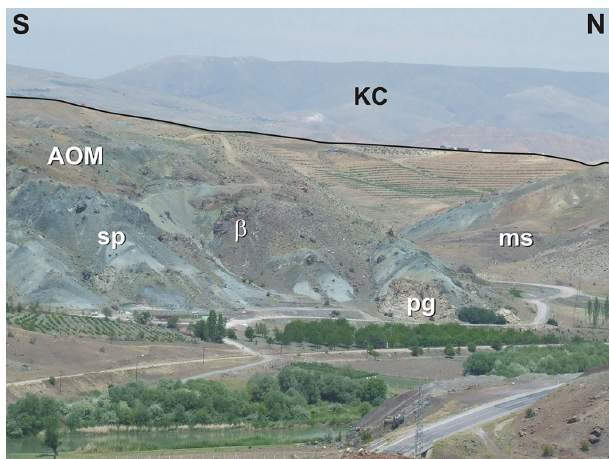
Fig. 5. View of the Ankara Mélange and the Karakaya Complex (Sakarya Continent). Key to lettering: AOM = Ankara Mélange, β = basalt, KC = Karakaya Complex, ms = mudstone, pg = pla- giogranite, sp = serpentinized